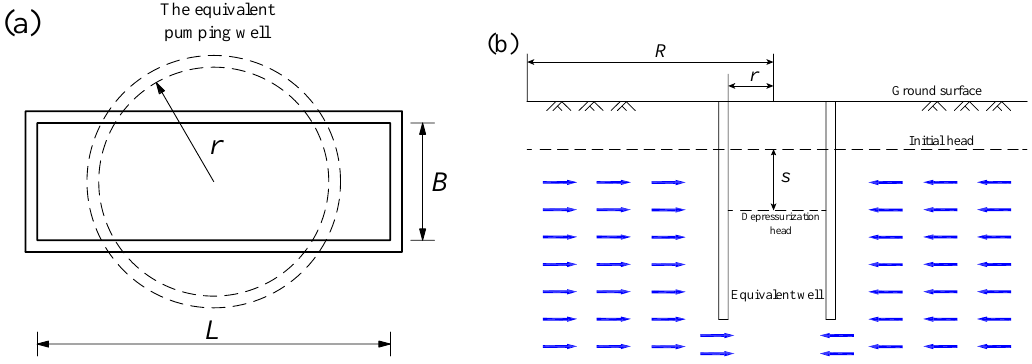
Figure 6. The equivalent pumping well: ( a ) Cross-section; ( b ) vertical section.